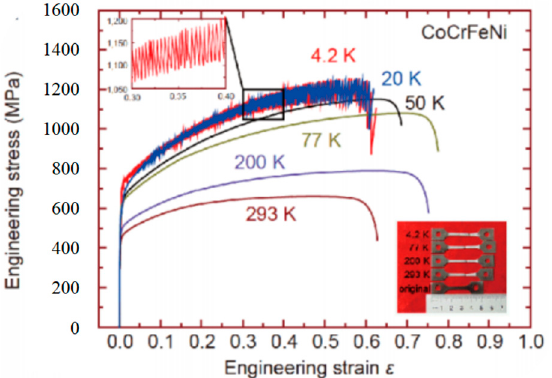
Figure 4. Engineering stress–strain curves and photograph of CoCrFeNi before and after tensile tests from room temperature to low temperatures. Reprinted with permission from Ref. [26]. Copyright 2018, Springer Nature.